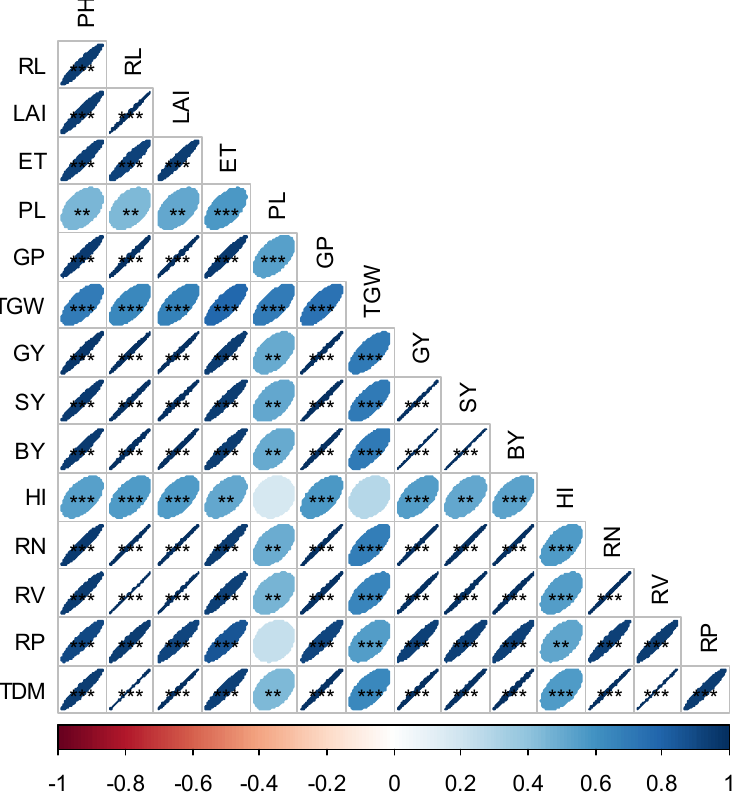
Figure 5. Correlation matrix and heatmap of the root parameters, growth attributes, yield parameters and yield. The ellipses in blue and red represent the positive and negative connections, accordingly. Greater color brightness exhibits the stronger coefficient. The ellipse’s shape emphasizes the extent of homogeneity of the connections. ** and *** indicate 1% and 0.1% levels of significance, respectively. Traits descriptions: PH—plant height; No. ET—number of effective tillers; RN-root number; RL—root